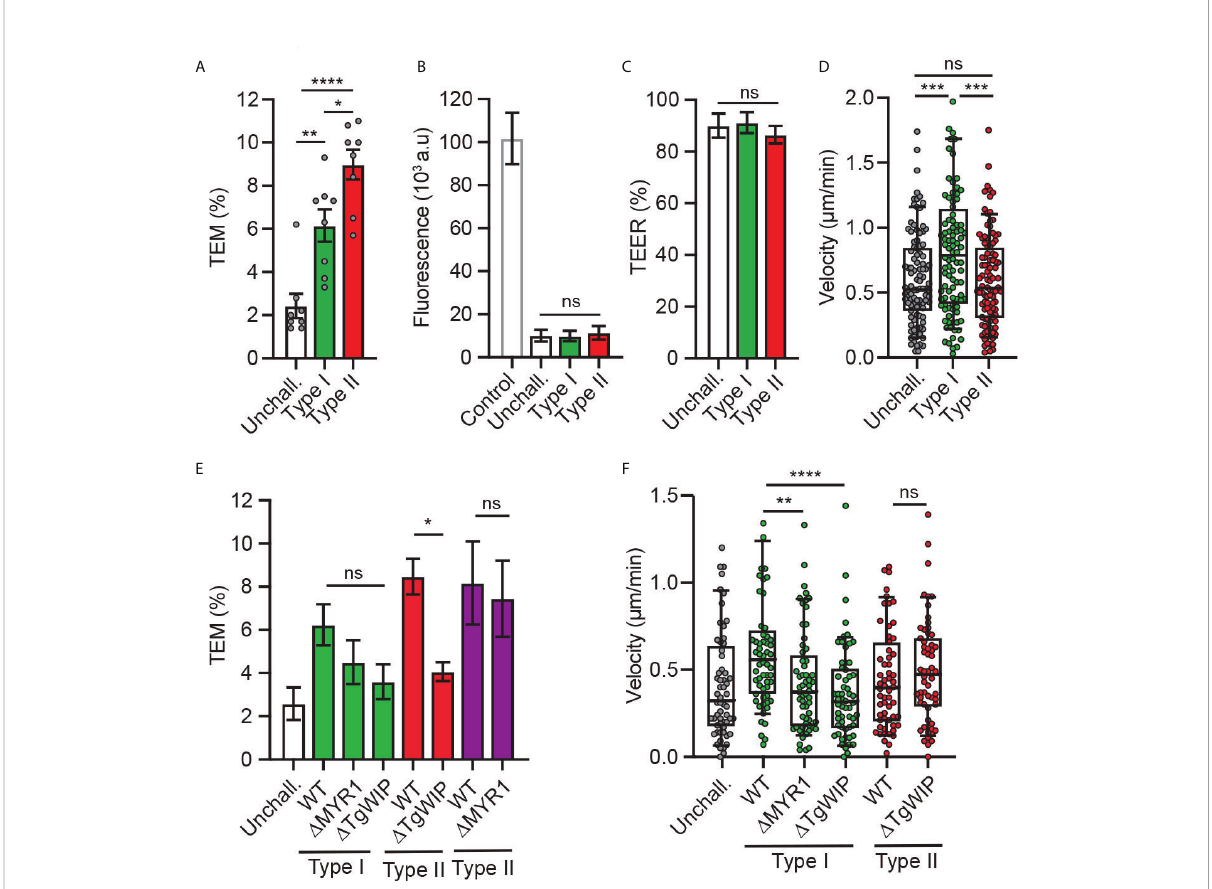
FIGURE 1 Transmigration and motility of T. gondii -challenged DCs on bEnd.3 monolayers. (A) Transendothelial migration (TEM) frequency of unchallenged or T. gondii -challenged (type I or II) DCs across bEnd.3 cell monolayers shown as percentage (%) of DCs added in the upper well. (B) Permeability of bEnd.3 monolayers to FITC-dextran (3 kDa) after DC TEM. Data are shown as arbitrary fl uorescence units (a.u.) as speci fi ed under materials and methods. (C) TEER values of bEnd.3 cells relative to TEER values at initiation of the assay (100%). (D) Box-and-whisker and scattered dot plots represent median velocities ( m m/min) of unchallenged and T. gondii -challenged DCs on bEnd.3 monolayers. Each dot represents one tracked cell (n = 100). (E) TEM frequencies of unchallenged DCs or DCs challenged with type I (RH; green bars) or type II (ME49-PTG; red bars, PRU; purple bars) WT or mutant strains across bEnd.3 cell monolayers shown as percentage (%) of DCs added in the upper well. (F) Box-and-whisker and scattered dot plots represent median velocities ( m m/min) of unchallenged and T. gondii -challenged DCs on bEnd.3 monolayers. Each dot represents one tracked cell (n = 60). Bar graphs represent the mean ± s.e.m of 3-4 independent experiments. * P < 0.05, ** P < 0.01, *** P < 0.001, **** P < 0.0001, ns: non-signi fi cant, by one-way ANOVA, Sidak ’ s post-hoc